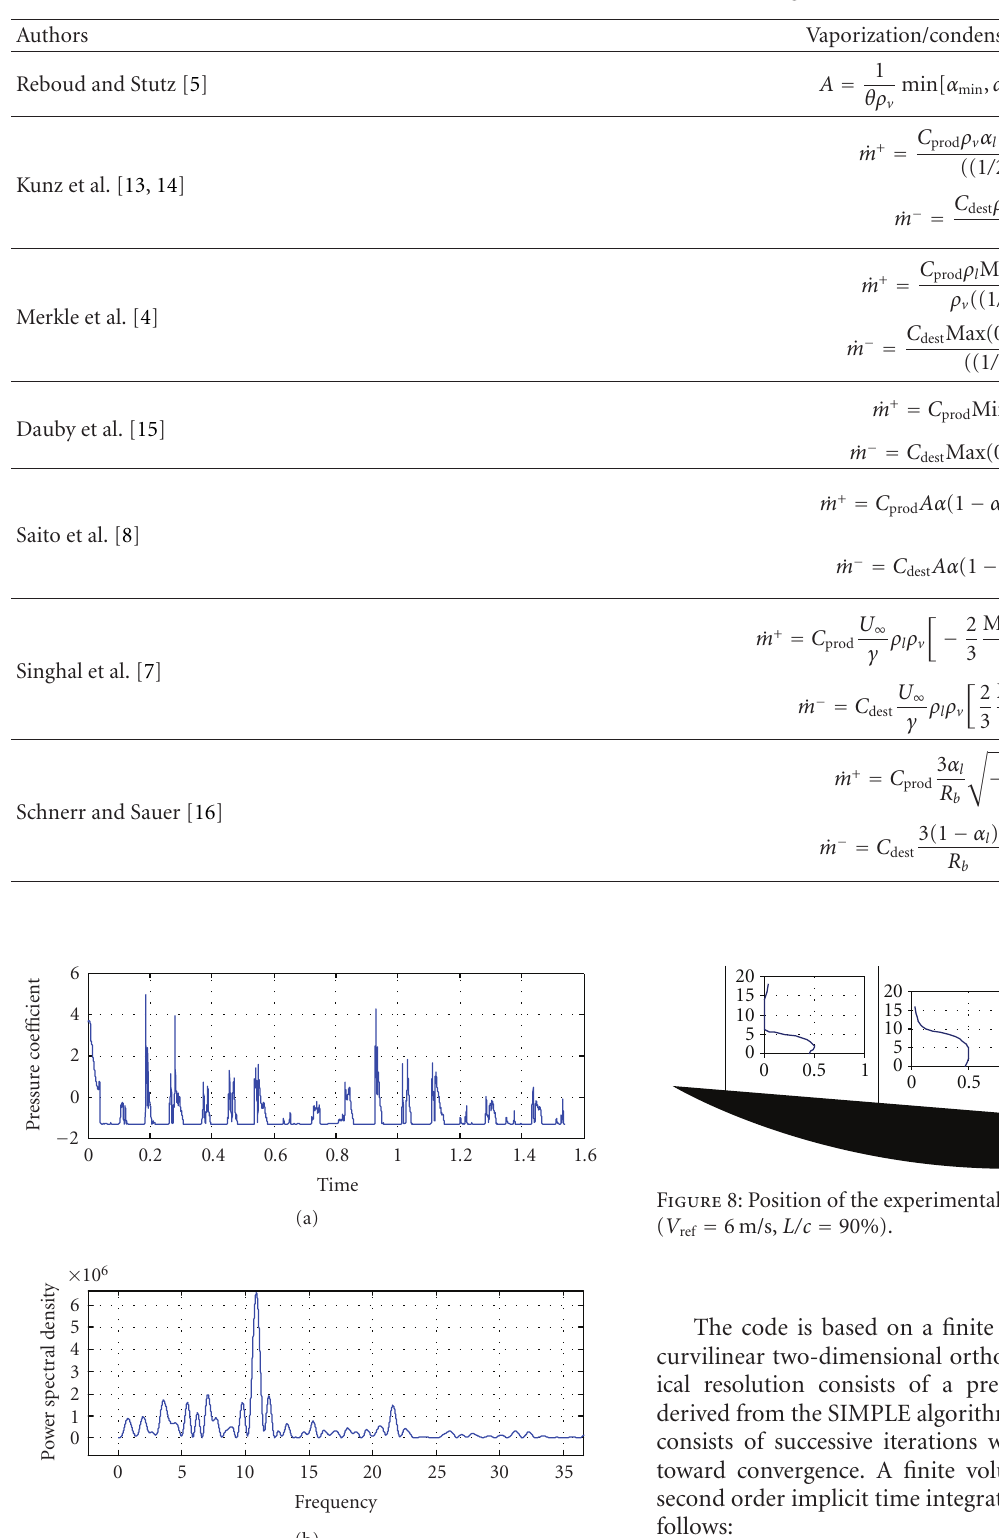
Table 1: Overview of some cavitation models existing in the literature.